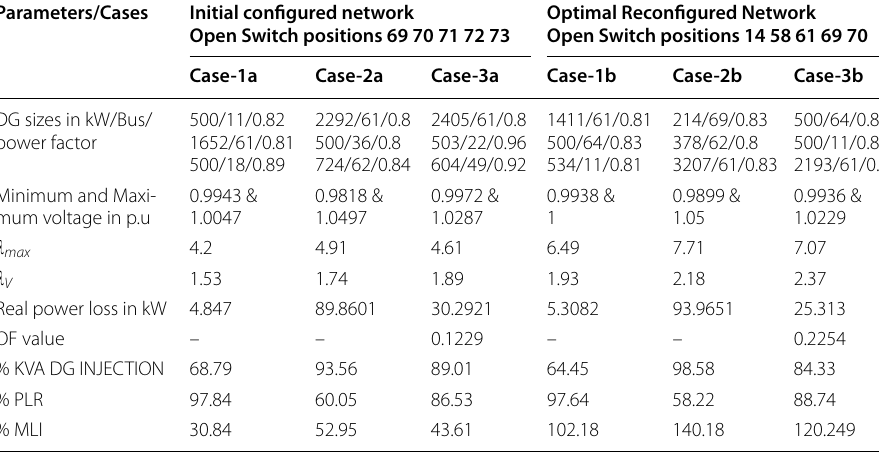
Table 6 Simulation results of 69 bus system for scenario-1